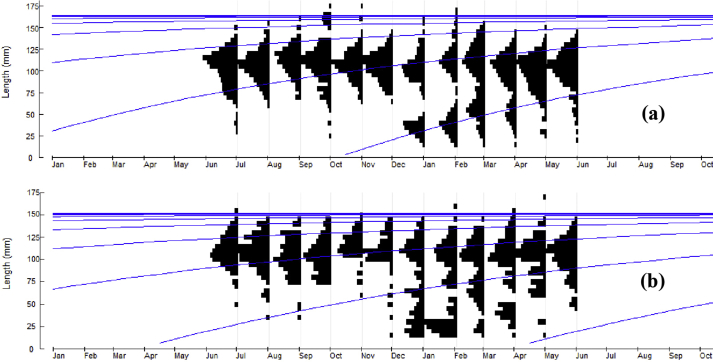
Von Bertalenffy growth curves of (a) male and (b) female S. olivacea drawn over their restructured length distribution.